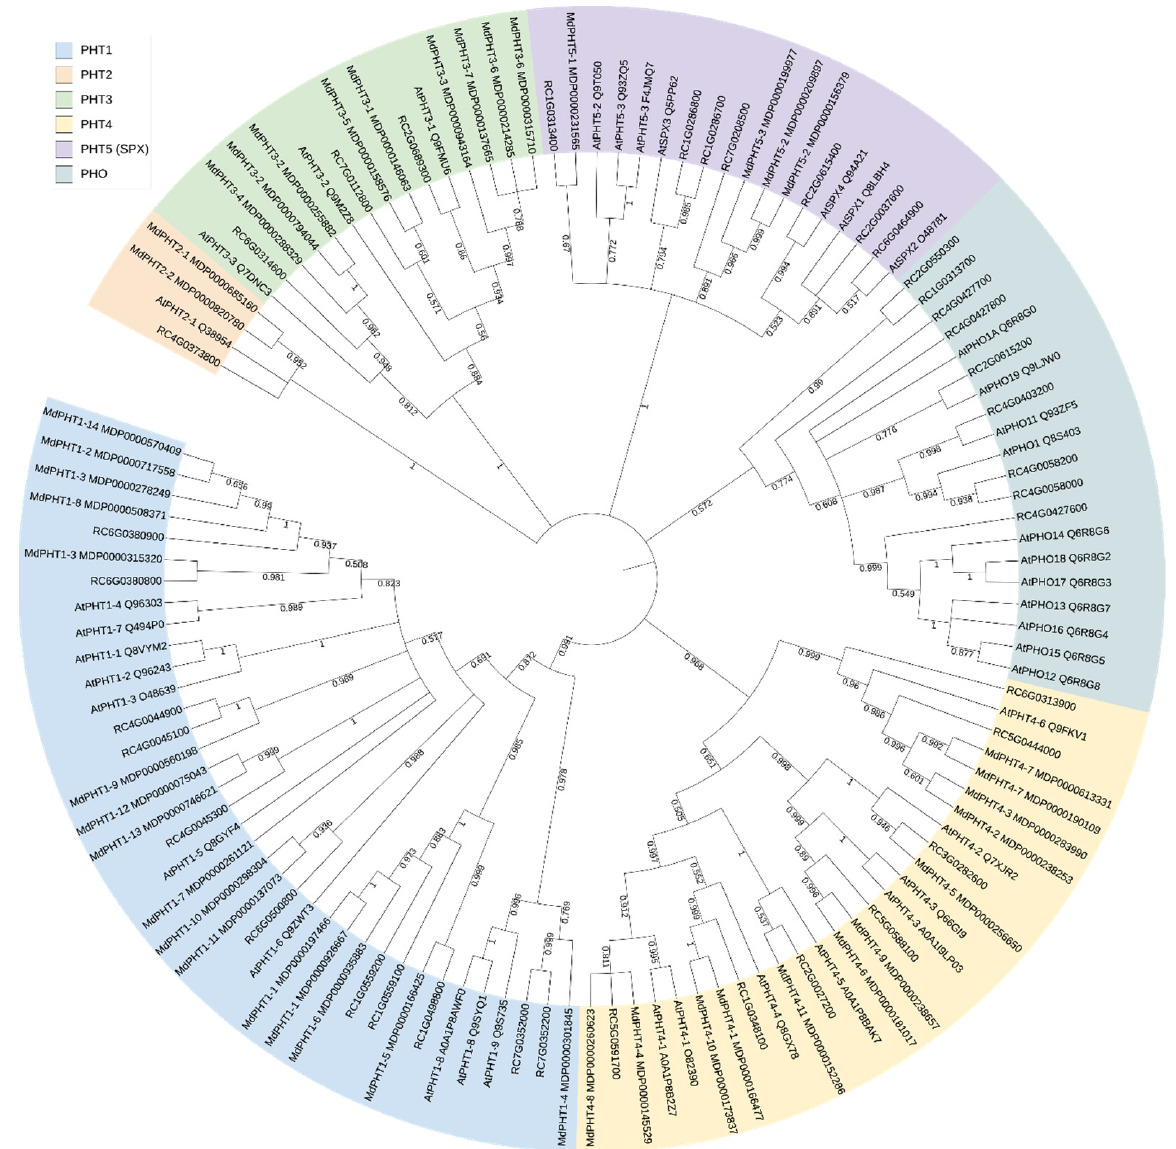
Figure 2. Phylogenetic analyses of PHT proteins in Arabidopsis thaliana (At), Rosa chinensis (Rc) and Malus domestica (Md). Evolutionary analysis by maximum likelihood method and JTT matrix-based model using MEGA X and 1000 bootstraps. The percentage of trees in which the associated taxa clustered together is shown next to the branches.